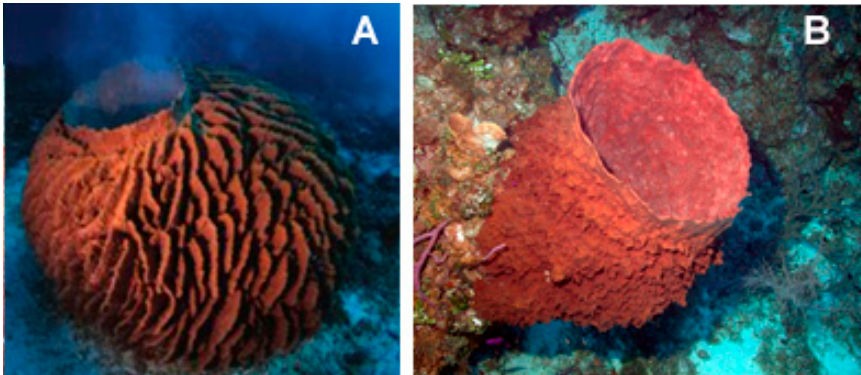
Figure 15. Two examples of species of the genus Xestospongia . ( A ) Xestospongia testudinaria (Lamark,